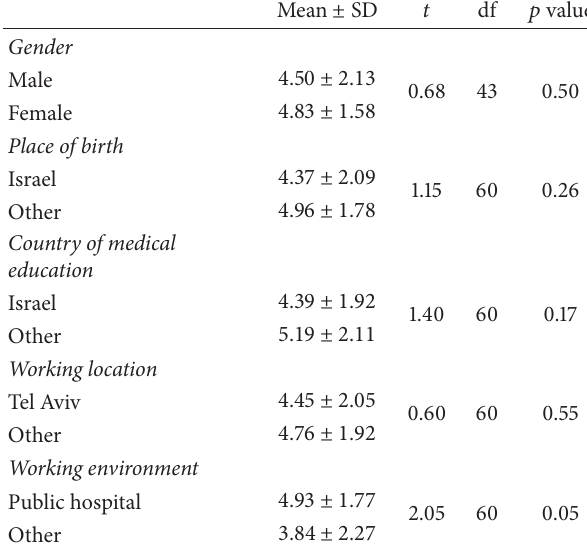
Table 4: Differences in gastroenterologists’ rankings of supporting DRD of endoscopic procedures, based on demographic and educa- tional